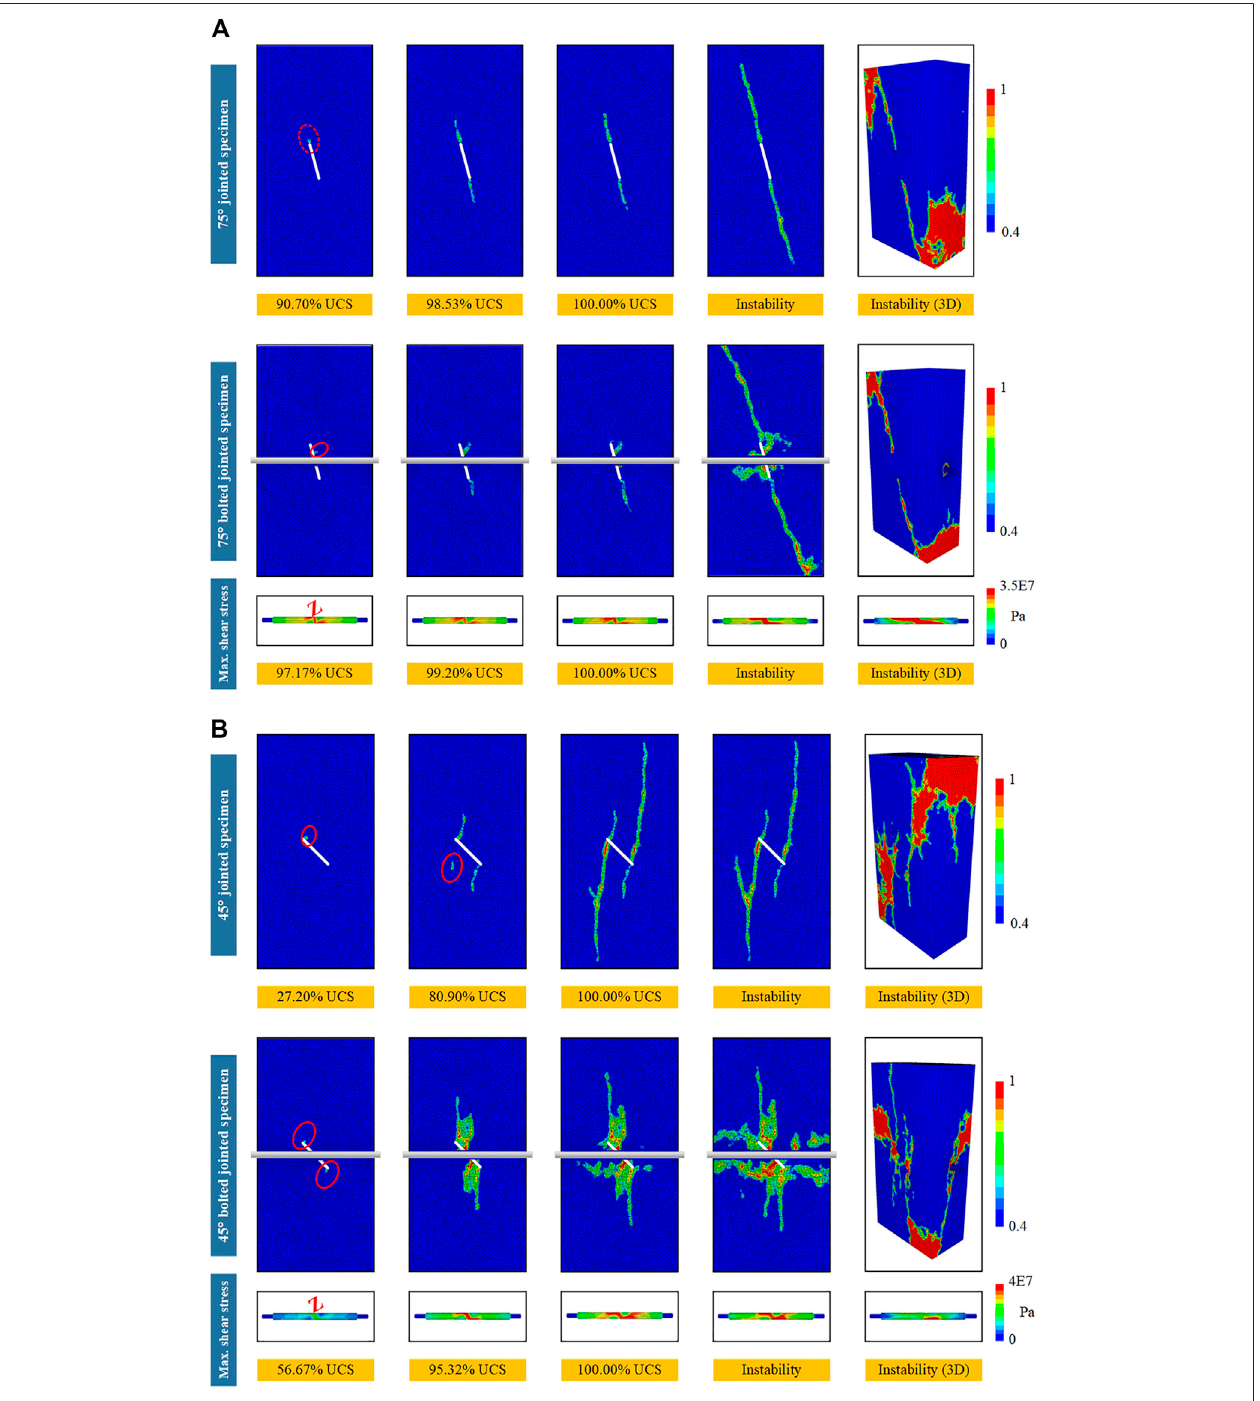
FIGURE 11 | Damage evolution of jointed and bolted jointed specimens under uniaxial compression and maximum shear stress of the bolt: 75 ° jointed and bolted jointed specimens (A) and 45 ° jointed and bolted jointed specimens (B) .